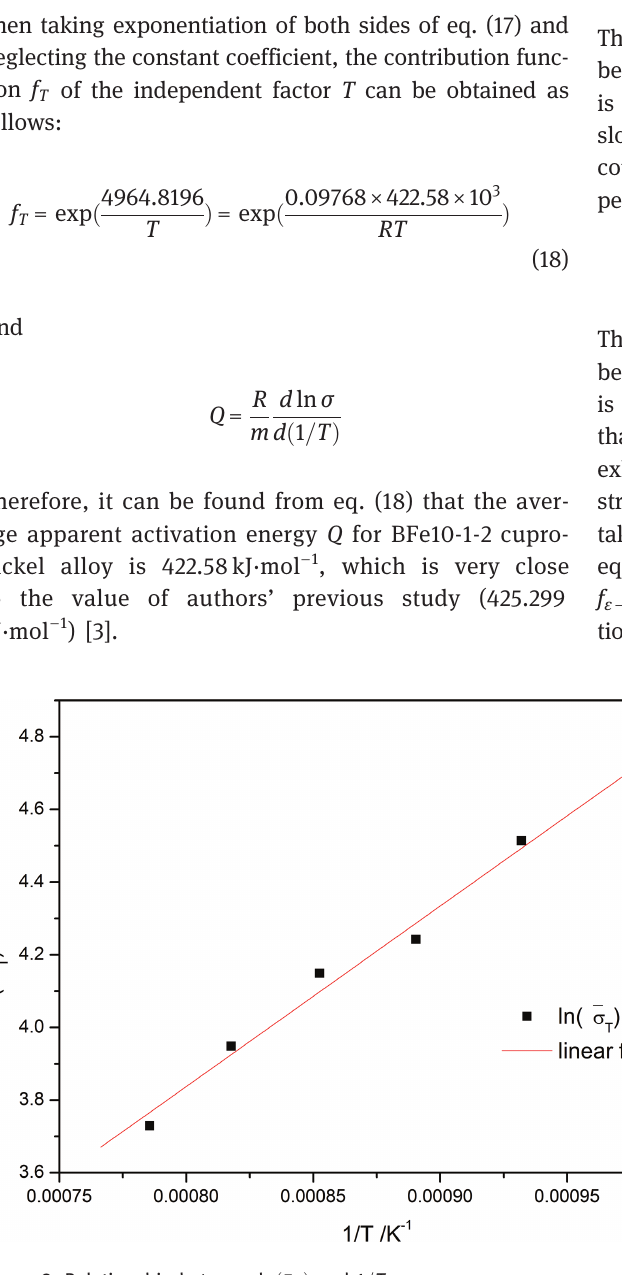
Figure 9: Relationship between ln ð (cid:2) σ T Þ and 1 = T